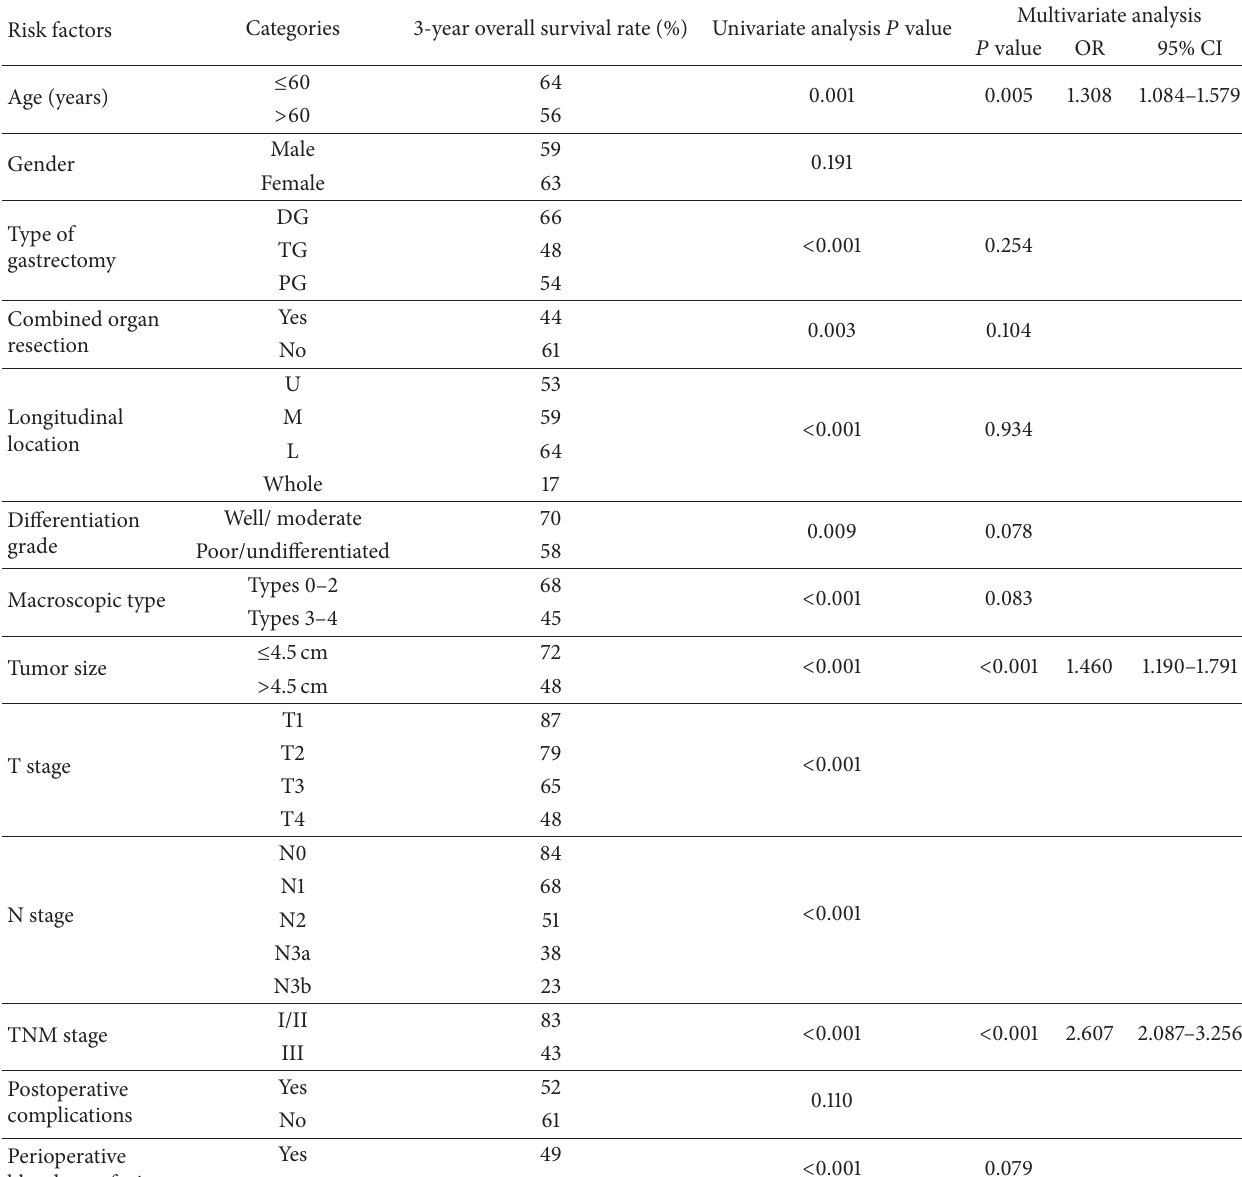
Table 5: Univariate and multivariate Cox analysis for prognostic